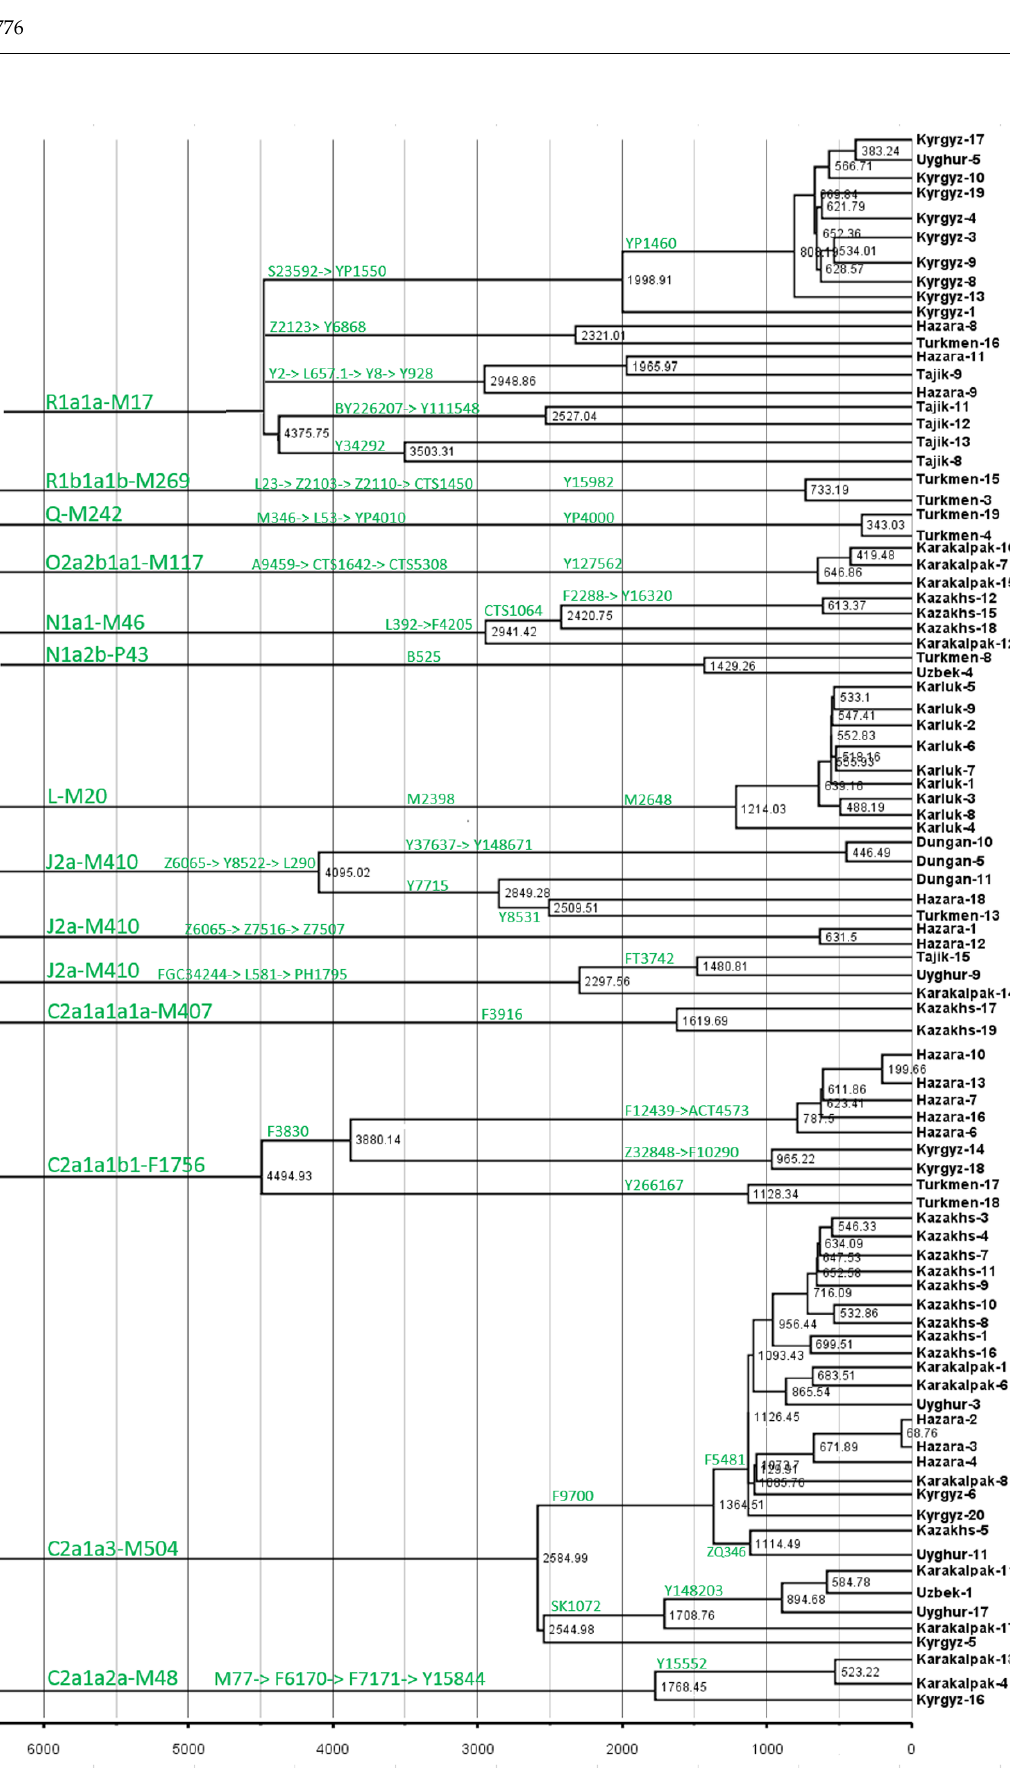
Figure 3. Schematic tree of unique minor lineages in populations from Central Asia.